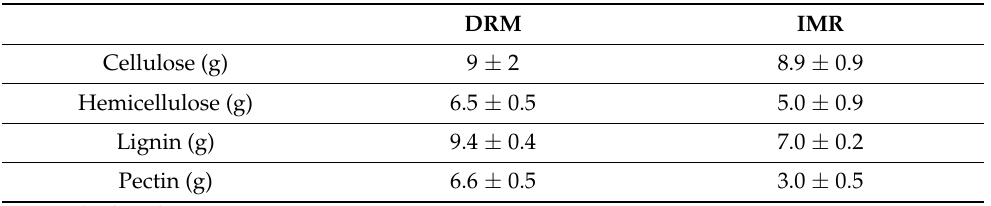
Table 1. Composition of detergent fibers and Pectin in DRM and IMR.